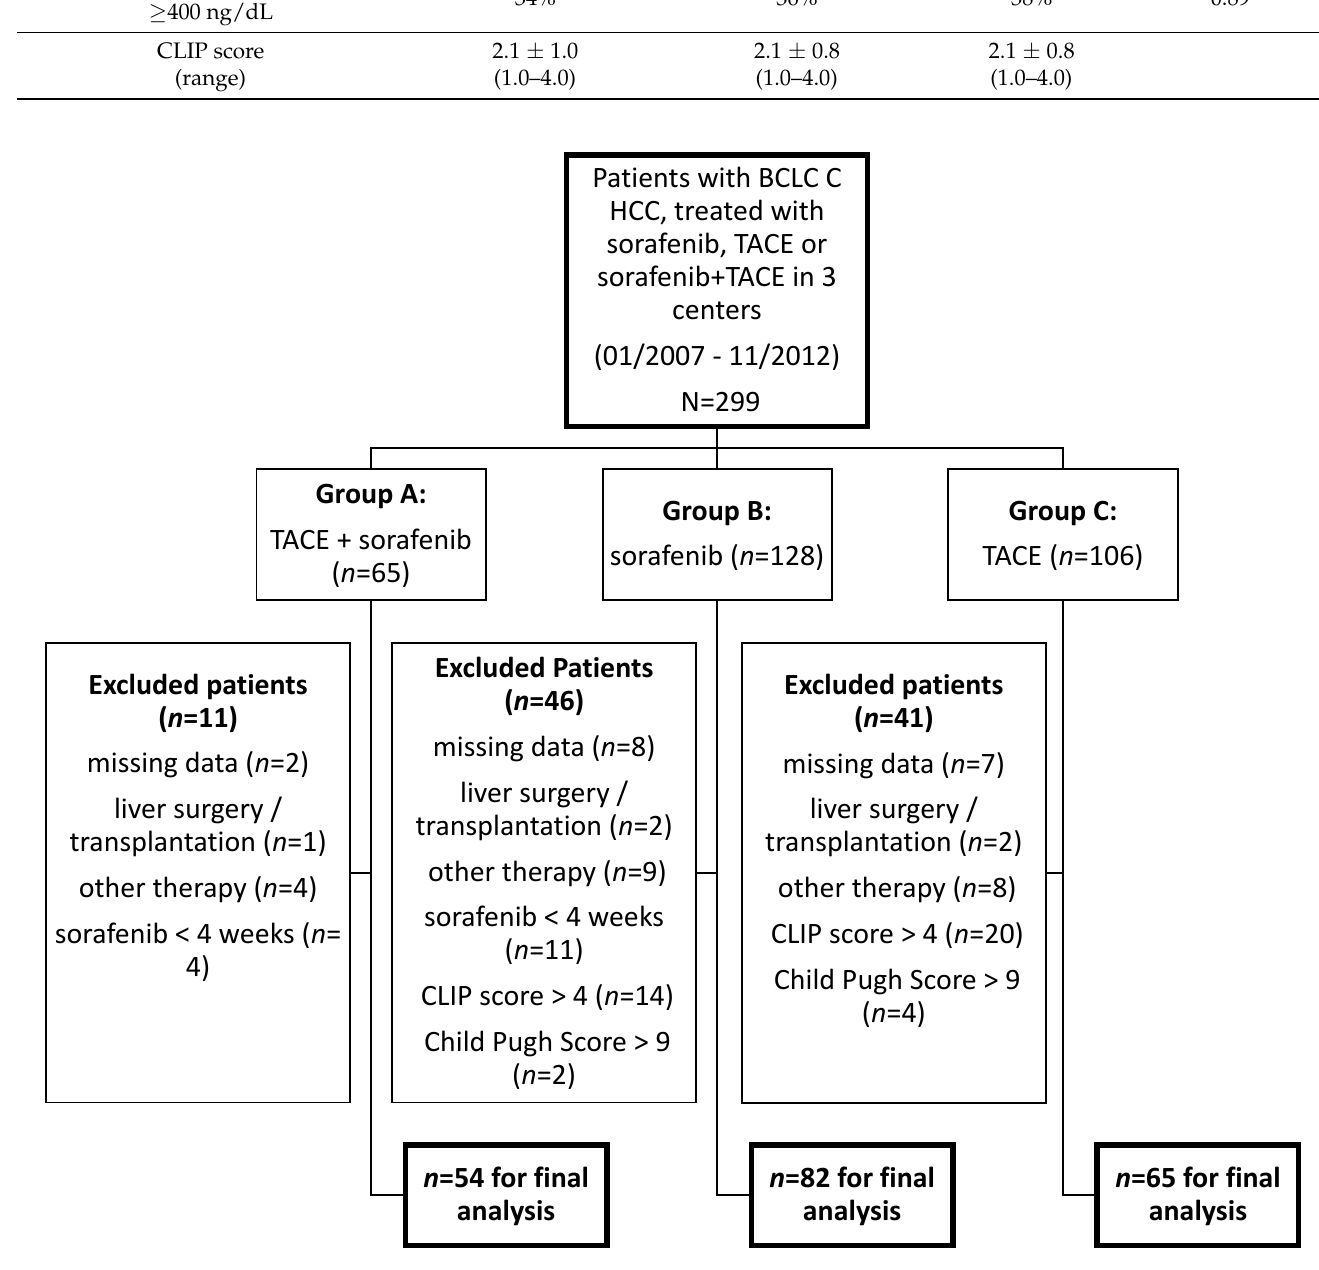
Figure 1. Patient Figure 1. Patient characteristics.